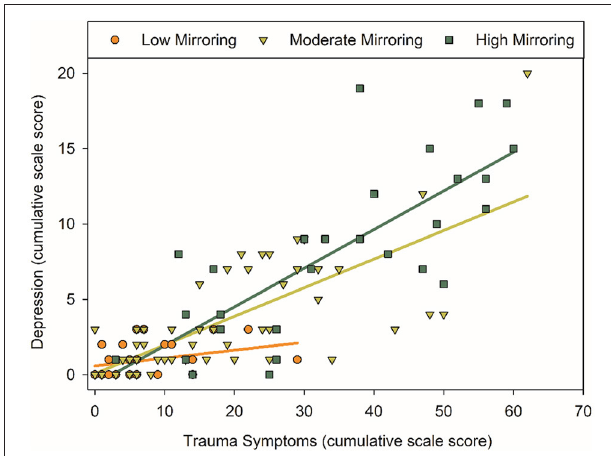
FIGURE 1 | The association between PTSD and depression symptoms was moderated by Mirroring need. All analyses treated cumulative scale scores as continuous variables; for the purpose of illustration, Mirroring need is depicted at low ( ≥ 25 th percentile), moderate, and high ( ≥ 75 th percentile) levels as observed in the sample. Higher PTSD symptoms were positively correlated with higher depression symptoms. This association was more strongly positive at moderate and high levels of Mirroring ( b = 0.003, p = 0.01, 1 R 2 = 0.02). Depression scores 11 and higher indicate “severe” to “extremely severe” levels; notably individuals who reported lower Mirroring need did not pass this threshold despite reporting elevated PTSD